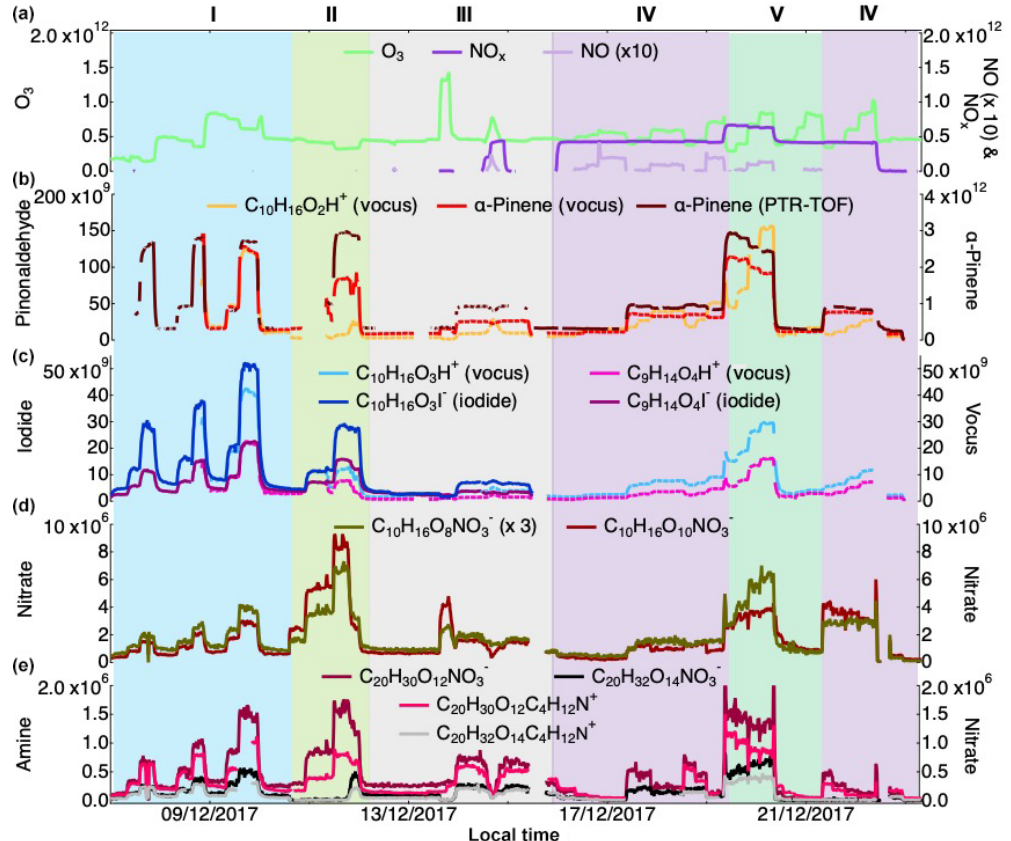
Figure 1. Campaign overview, including the concentration of O 3 , NO, NO x (a) as well as α -Pinene measured by the vocus and the PTR-TOF and pinonaldehyde measured using the vocus (b) . Concentrations of pinonic and pinic acids ( vocus and iodide ) are presented in (c) , example of HOM monomers from nitrate (d) and example of HOM dimers from amine and nitrate (e) . Concentrations for all the gaseous species are in molecules cm − 3 ; see text for details on quantification. The experiments were separated into five types: I is α -Pinene + O 3 , II is α -Pinene + O + CO (as an OH scavenger), III is tests (NO + O + NO and V is 3 2 injection, H 2 O 2 injection for generating HO 2 ), IV is α -Pinene 3 α -Pinene + O 3 + NO + CO. Concentrations of NO and C 10 H 16 O 8 NO − are scaled for 3